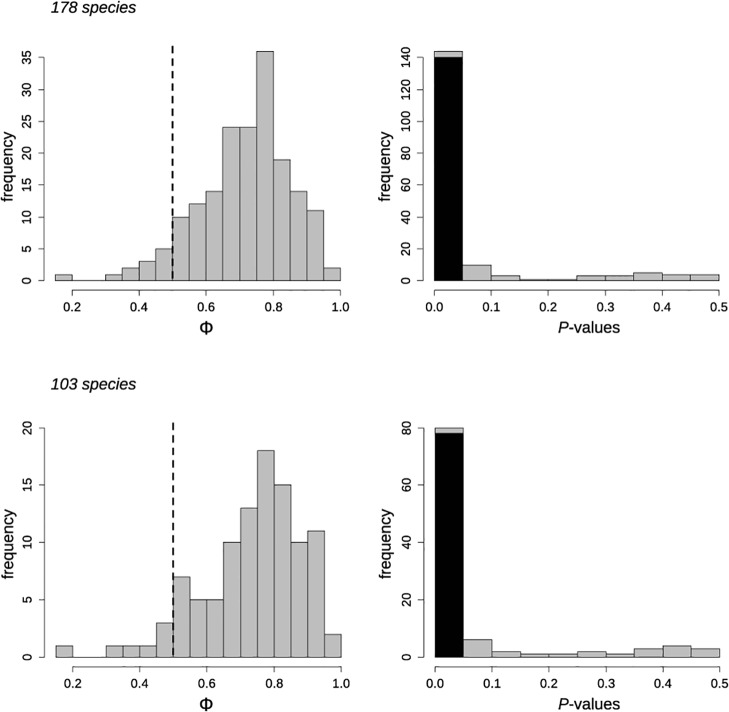
Frequency distribution of phi indices (Φ) and their associated P-values of the avian species studied.Results using all species (N = 178) or only the species not tested previously (N = 103) are shown separately. Vertical dashed-line indicates the null expectation of Φ (0.5). Black bars indicate the frequency of species that significantly flushed early (i.e., P-values < 0.05).